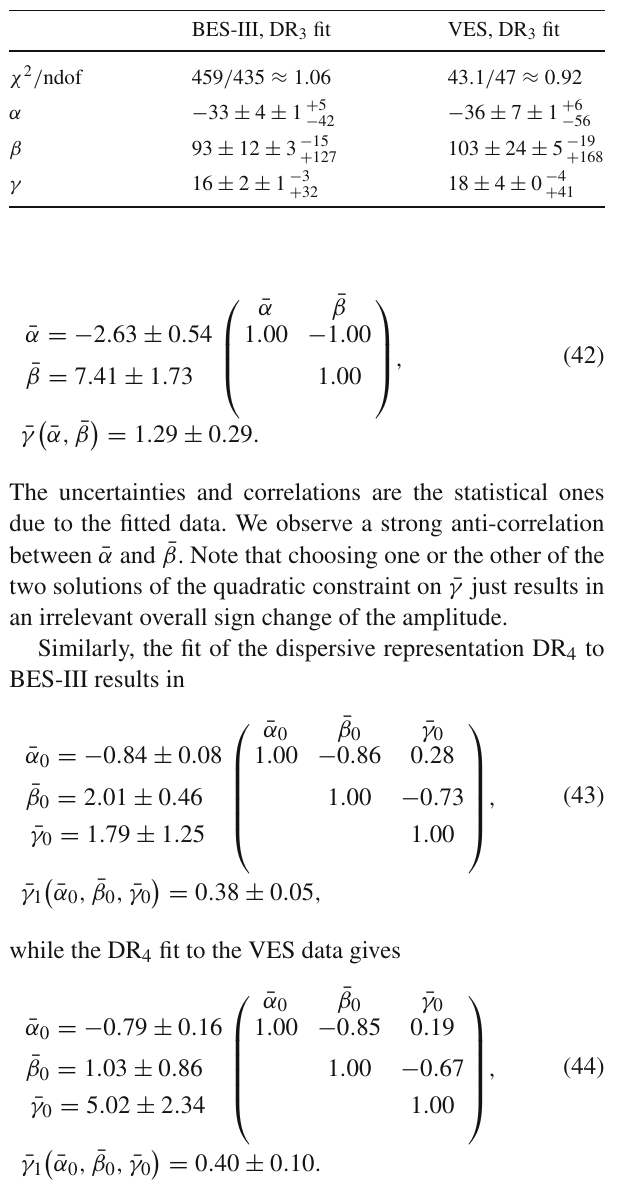
Table 2 Fit results for the DR 3 subtraction constants for the BES-III and VES data samples. The first error gives the combined uncertainty of the Dalitz-plot data and the partial decay width of η (cid:2) → ηπ + π − , while the second (asymmetric third) error gives the uncertainty due to the ππ ( πη ) phase